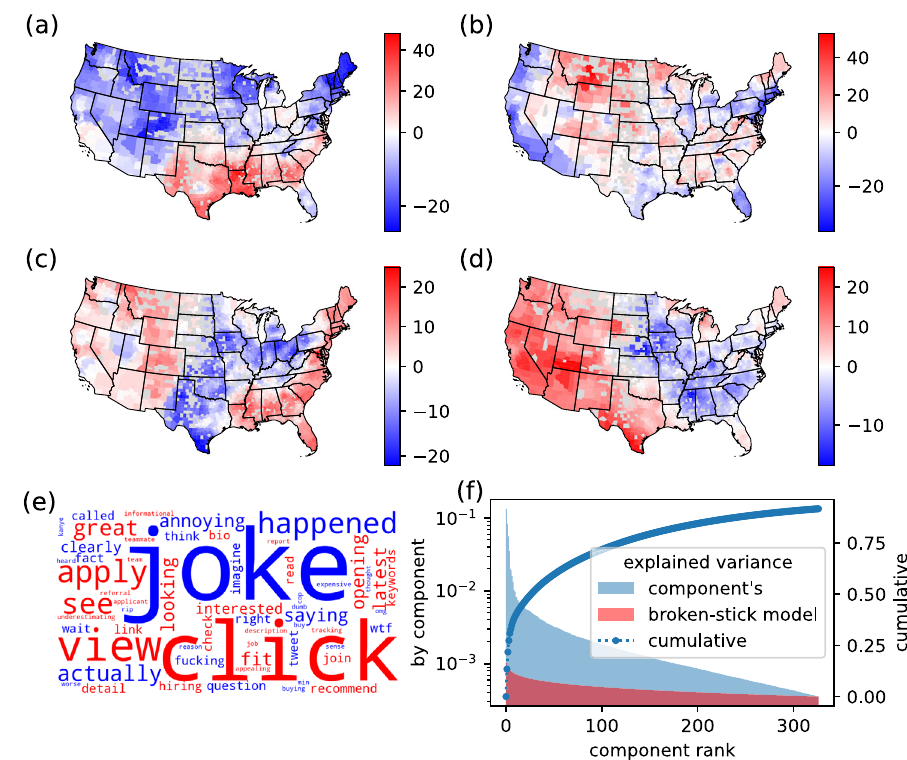
Fig. 3 Result of the principal component analysis carried out on our whole dataset. a – d Four maps show the projection of the data along the fi rst four components, highlighting regional lexical variations. Note that the scale on the divergent color scales is not symmetrical around zero in order to utilize the full range of colors of the color map. e Word cloud showing the words with the strongest positive (red) and negative (blue) loadings for the second component, with each word ’ s font size depending on its loading ’ s absolute value. f Explained variance of the principal components compared to the broken- stick model on a logarithmic scale, which shows how the number of components to keep is selected at the fi rst intersection of the two curves. The cumulative proportion of the variance explained by the components is also plotted, showing that our dimension reduction explains around 92% of the observed variance. The fi rst four components shown in panels a – d capture alone 31% of the and blue) which can be linked to their characteristic words, the ones with the highest (positive, in red) and lowest (negative, in blue) loading. For an illustration, in Fig. 3e we show in a word cloud the most characteristic words for each of the two regions in Fig. 3b, which corresponds to the second component. In Figs. S2 and S3 we plot, respectively, the projected data for the proximity of Eq. (1) de fi ned based on the 5 and 15 nearest matrix W c ; c 0 signi fi cantly altered by a slight change in the proximity matrix.